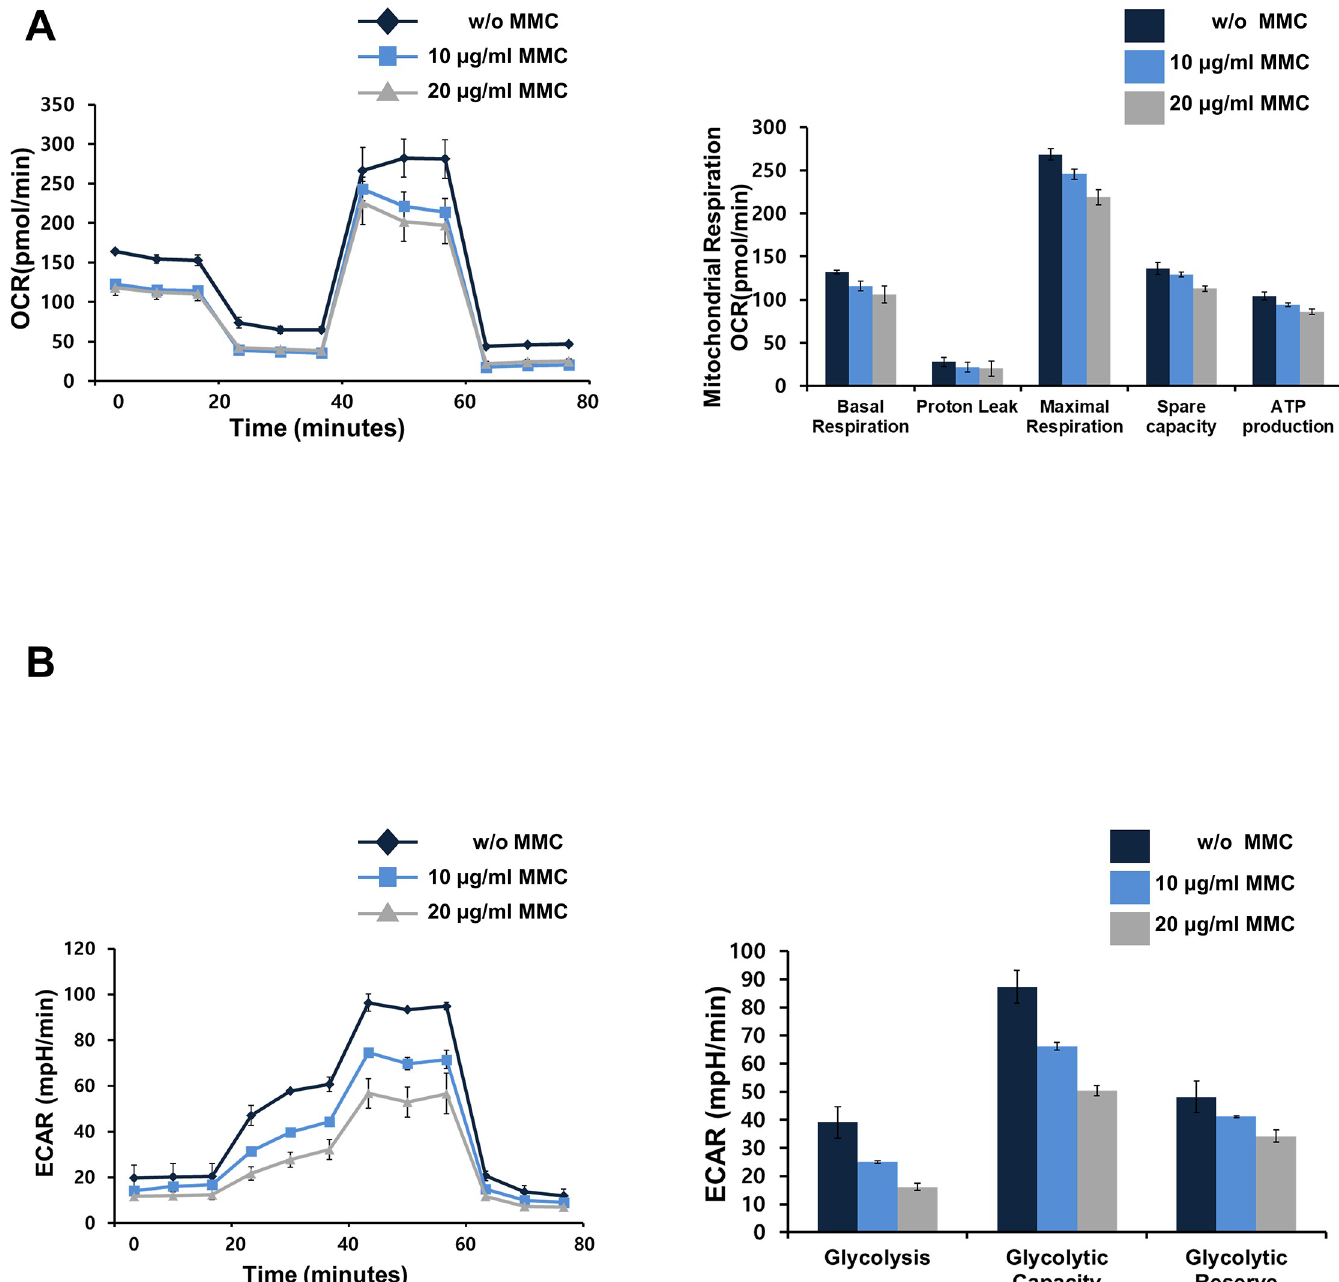
Fig 4. Comparison of metabolic ability with MMC treatment concentration. (A) Oxygen Consumption Rate (OCR) and (B) Extracellular Acidification Rate (ECAR) of fibroblasts treated with 0, 10, and 20 μ g/ml. In the case of 0 μ g/ml (without) treated group, fibroblasts cultured in the nanopatterns were used as a control group.